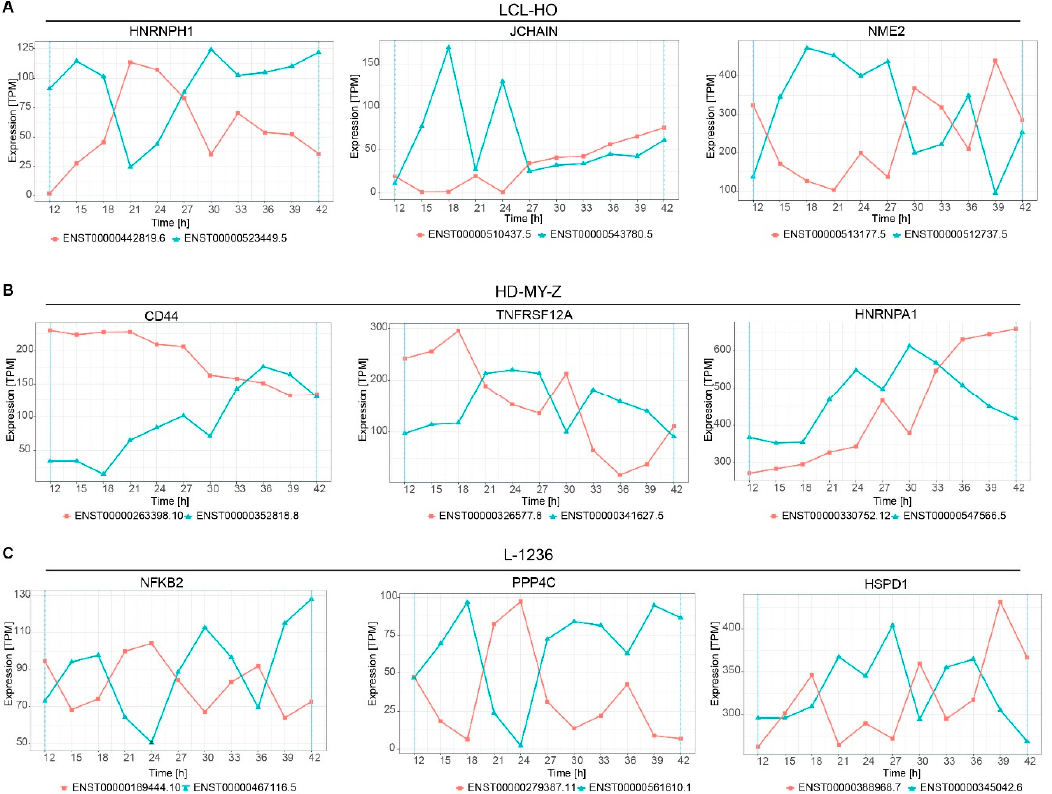
Figure 4. Several of the genes with largest expression difference between the switching isoforms are related to the tumour necrosis factor (TNF)-signalling pathway. ( A ) Out of the top 20 genes with largest expression difference between the isoforms for the LCL-HO cell line are the JCHAIN , NME2 and HNRNPH1 genes, which depict remarkable difference in expression patterns over time. ( B ) Central genes involved in cancer metastasis such as CD44 undergo switching in isoform expression in HD-MY-Z. TNFRSF12A is related to the TNF-signalling pathway. ( C ) The changes in the expression of NFKB2 in L-1236 are associated to the TNF signalling pathway, and suggest possible rhythmicity of isoform expression switching. Also the expression changes between isoforms for PPP4C show a circadian